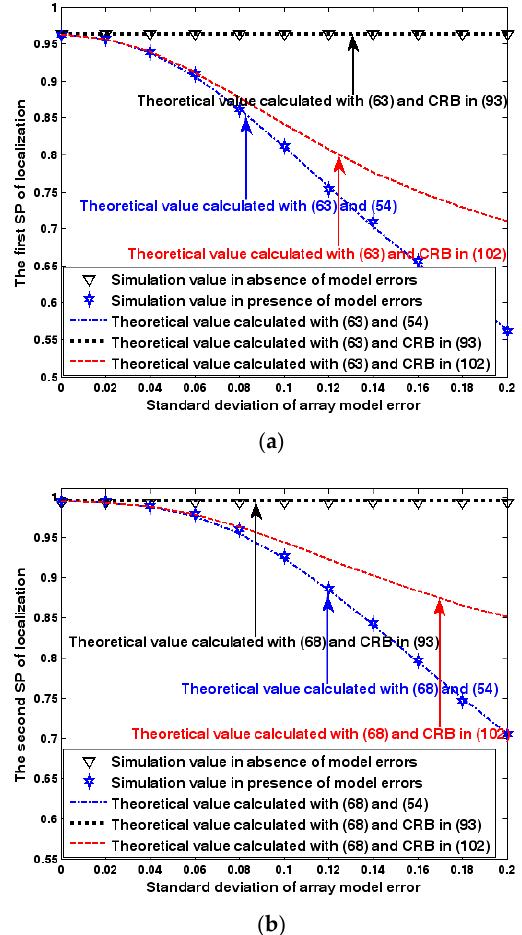
Figure 14. SP of localization versus standard deviation of array model error. ( a ) The first SP of localization versus standard deviation of array model error. ( b ) The second SP of localization versus standard deviation of array model error.